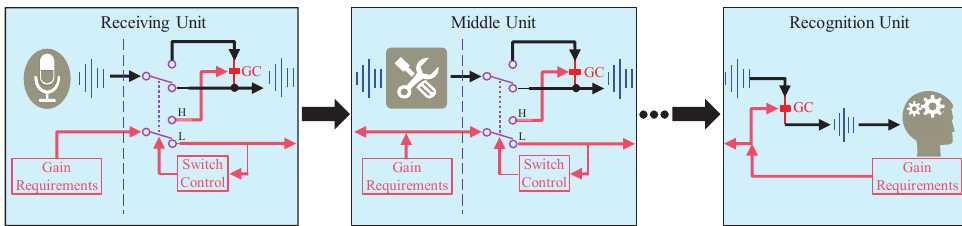
Figure 4. Proposed MOST gain control strategy for the ASR